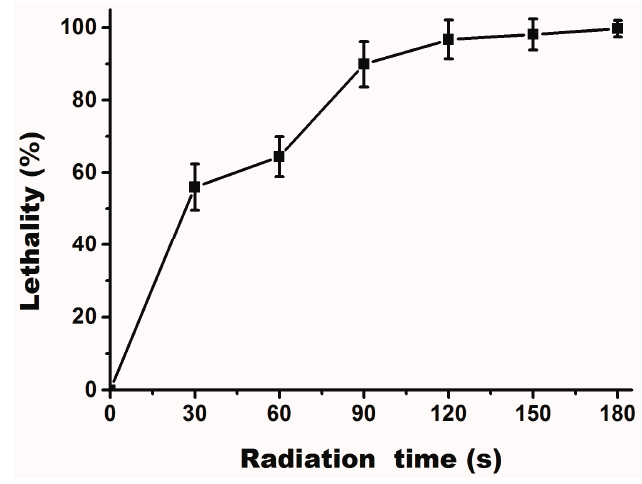
Figure 2. Death rate curve of Pseudochrobactrum sp. XF1 after different times of UV exposure. Error bars are the standard